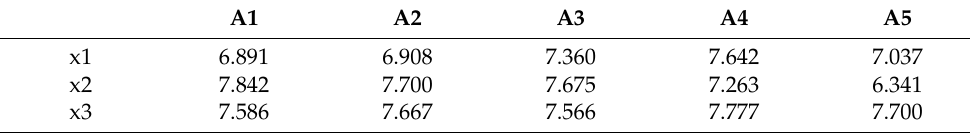
Table 6. The values of the dimensions. A1 A2